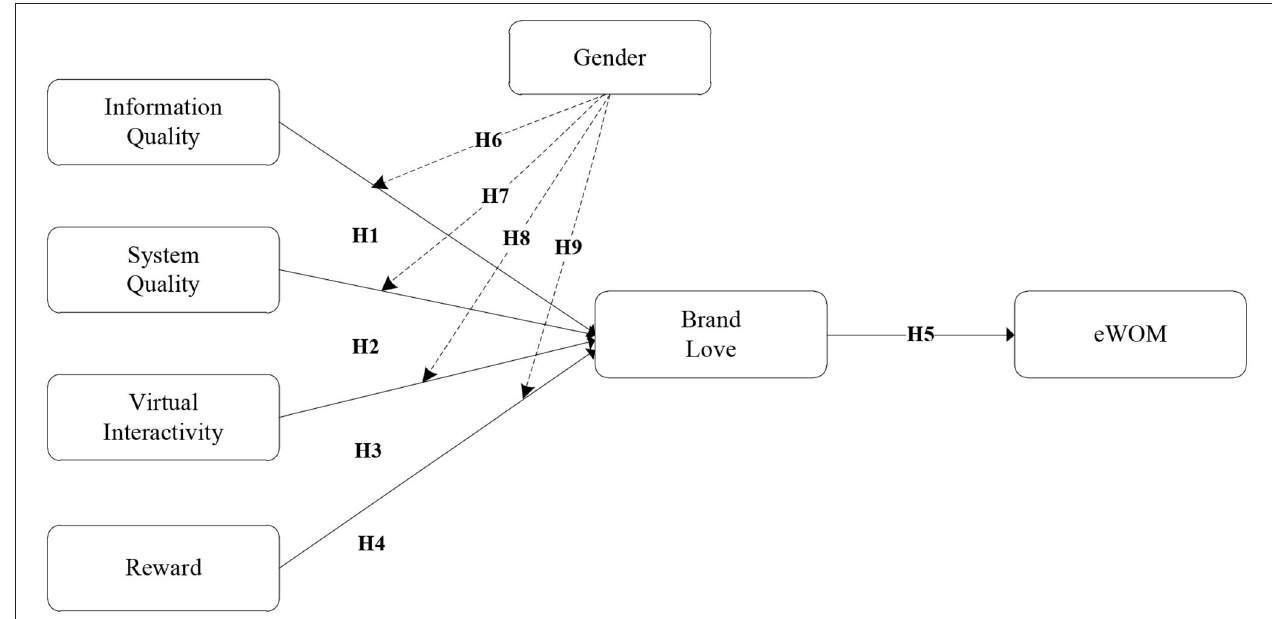
FIGURE 1 | Research